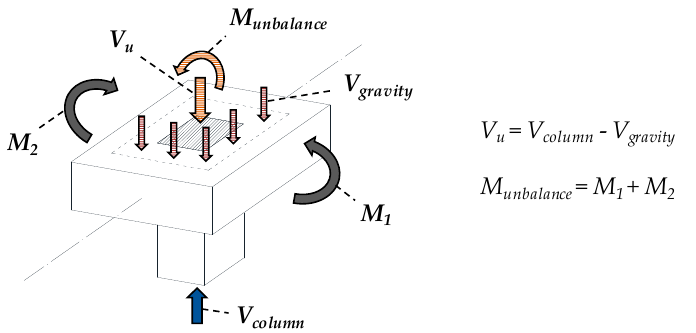
Figure 4. Definition of critical section.